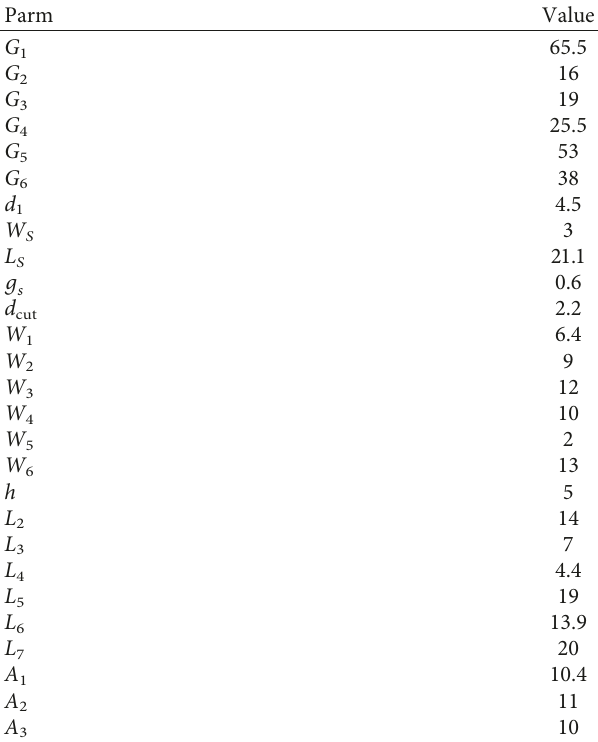
Figure 1: The proposed antenna. (a) The cross-sectional view of the antenna, (b) the (top) view of the radiator, and (c) the (bottom) view of the Table 1: Optimized geometric parameters (unit: mm).